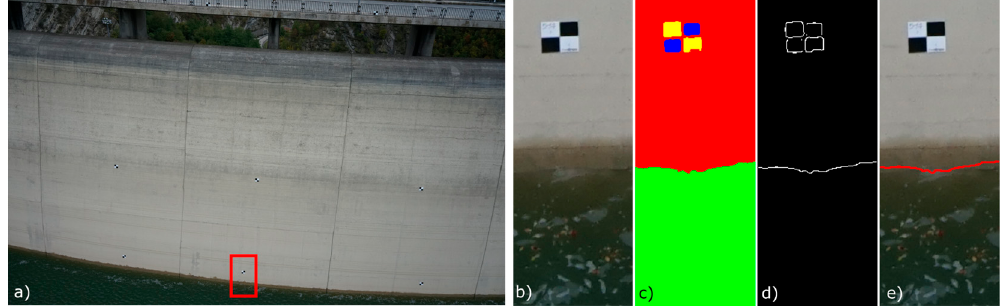
Figure 3. Panel ( a ) depicts one of the original images; ( b ) shows the image used to retrieve the water level value; ( c ) shows the results of the feature selection approach: elements are divided into four classes (i.e., water, concrete face, white and black parts of the marker); ( d ) shows the effect of the application of the Canny filter to categorize the image; ( e ) shows the extracted waterline.